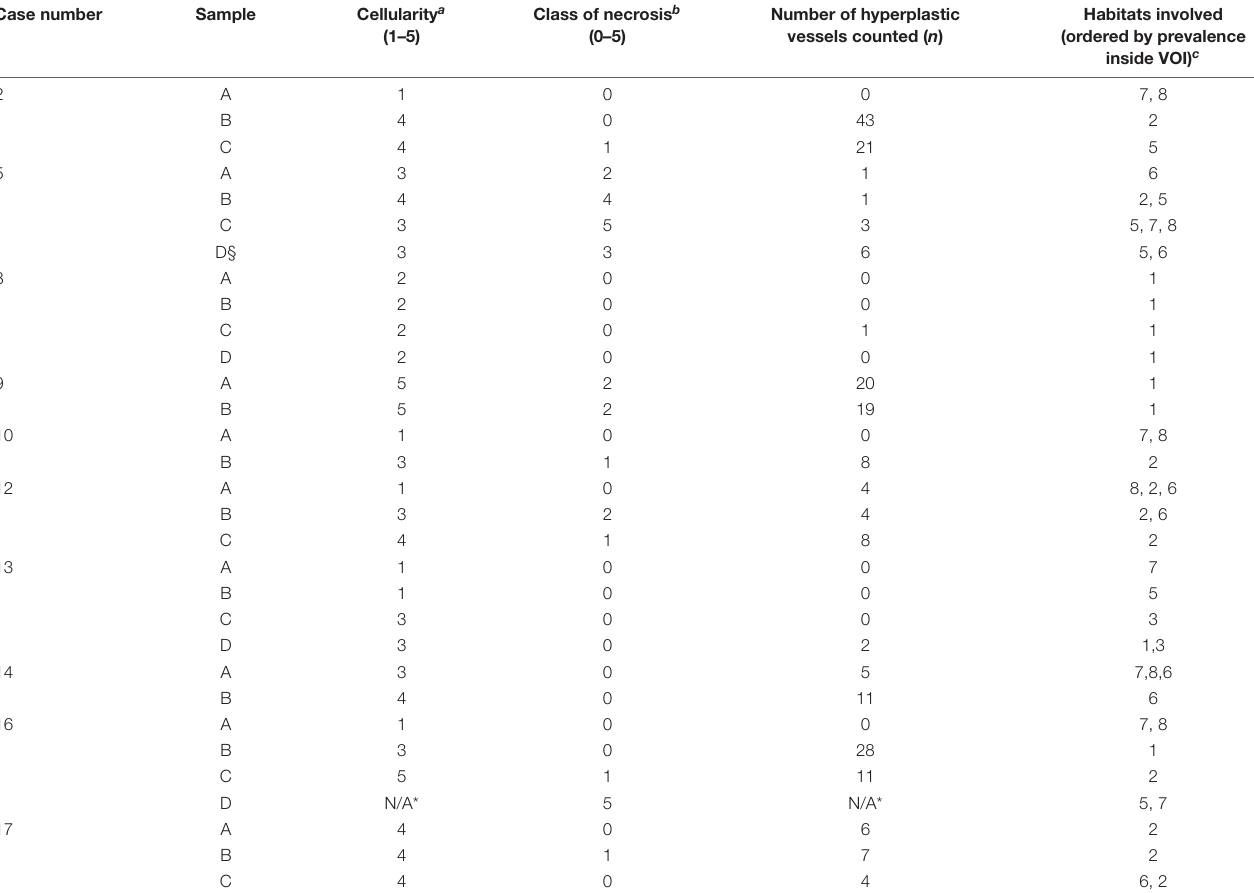
TABLE 4 | Semi-quantitative histopathologic analysis for each bioptic sample obtained. Case number